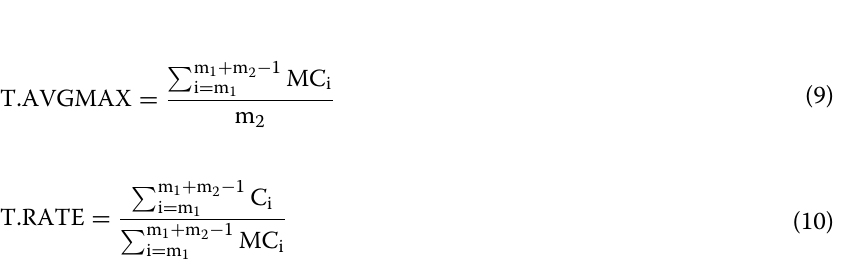
Fig. 4 Decision algorithm for n optimal and m optimal . For each picture on the left and right, n M m m m M − 1 , M and M + 1 means the Y and X‑axis of the environment, respectively. Each rectangle with the value means the common throughput value at the point of these Y and